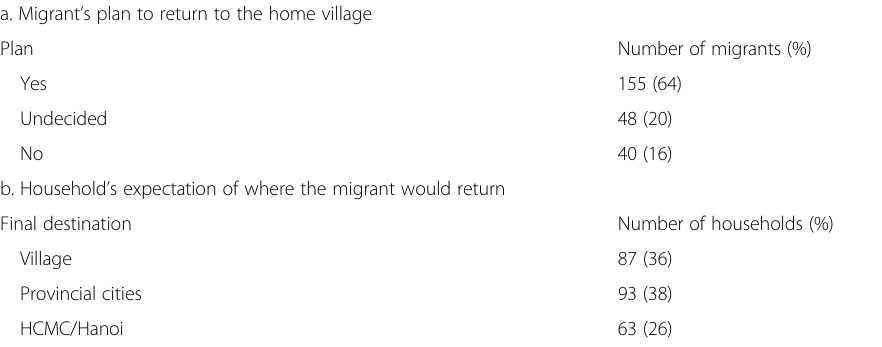
Table 3 Subjective plan of future location of migrants and their households a. Migrant ’ s plan to return to the home village